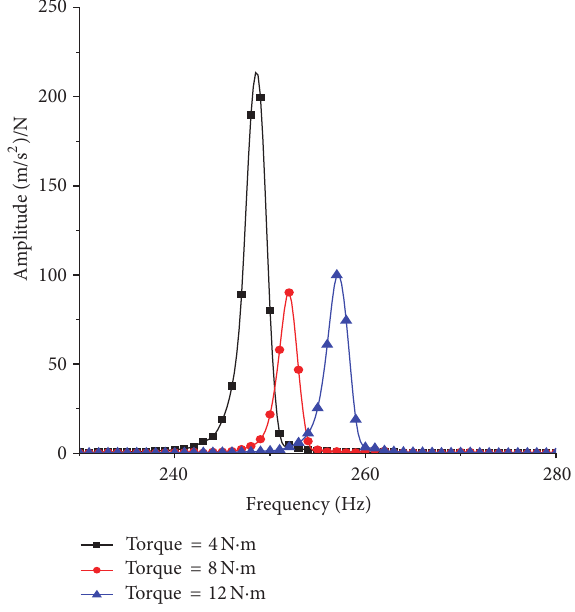
Figure 19: Frequency response functions of the second mode with impact levels 𝐹 exc = 100 N.